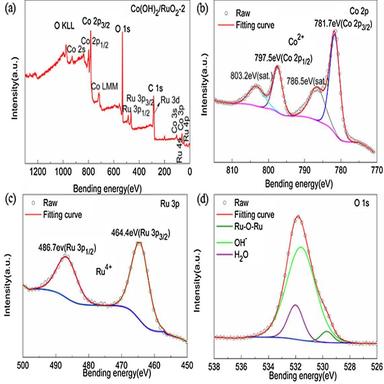
a) XPS survey spectrum of the Co(OH)2/RuO2-2; (b) Co 2p, (c) Ru 3p and (d) O 1s regions of the samples.